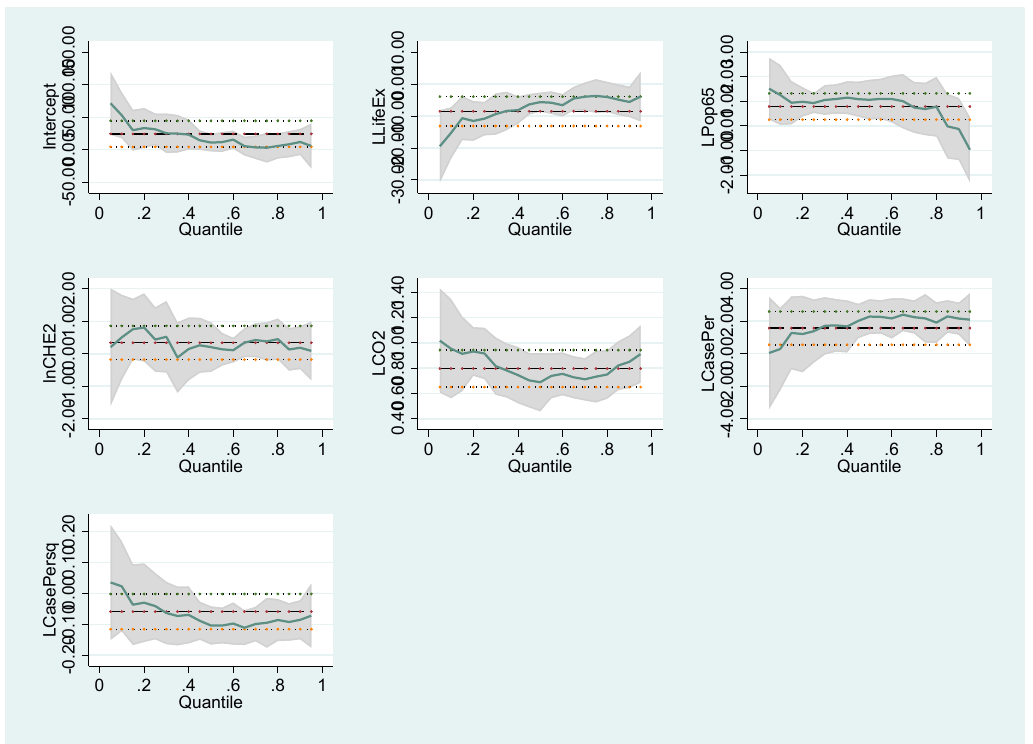
Figure 2. Changes in the quantile regression coefficients for Model II. Notes: The shaded bands rep- resent the corresponding 95% confidence intervals.